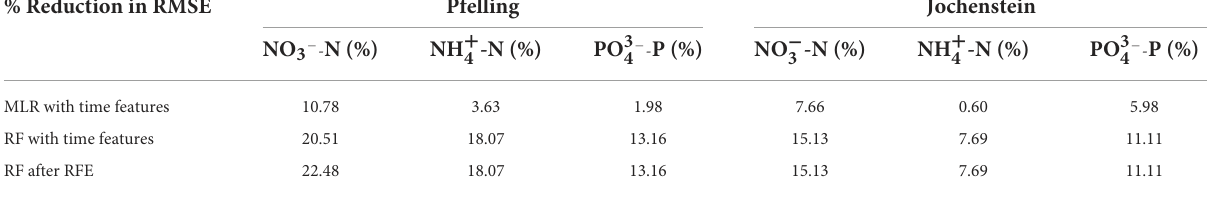
TABLE 6 Percentage of reduction in validate RMSE in linear models and non-linear models with time features and RFE. % Reduction in